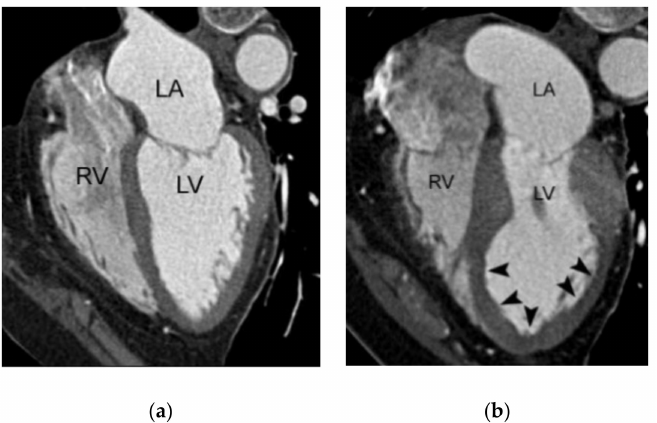
Figure 13. A case of stress-induced cardiomyopathy in a 65-year-old female patient identified on coronary CTA. Typical apical ballooning (arrowheads in ( b )) is noted on a systolic four-chamber image in comparison to a diastolic image ( a ). There was no obstructive coronary artery stenosis on coronary CTA or invasive coronary angiography (not